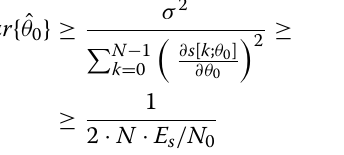
modified Cramer-Rao bound (MCRB) introduced in